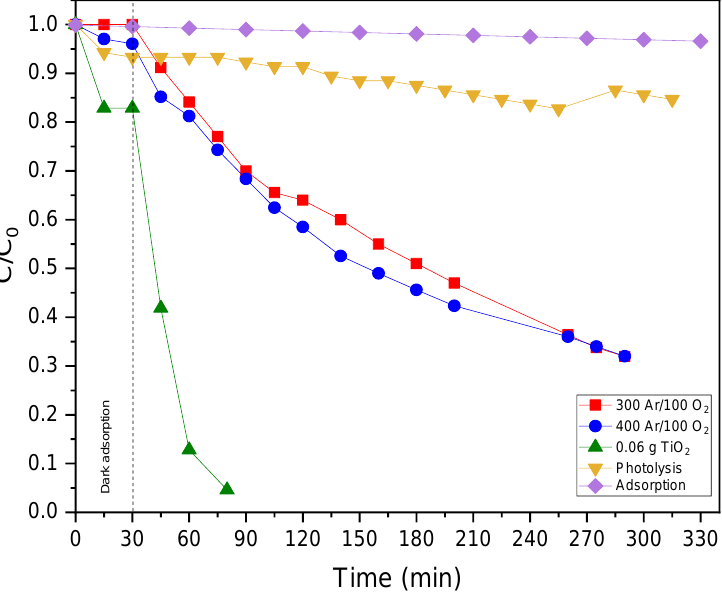
Figure 12. Change in rhodamine B concentration (2 L at 0.5 ppm RhB) with respect to time using different catalysts configurations. Arc-PVD Ag-TiO x coating (circle and square), anatase-phase TiO 2 powder catalyst (triangle), photolysis (inverted triangle), and adsorption (rhombohedra).